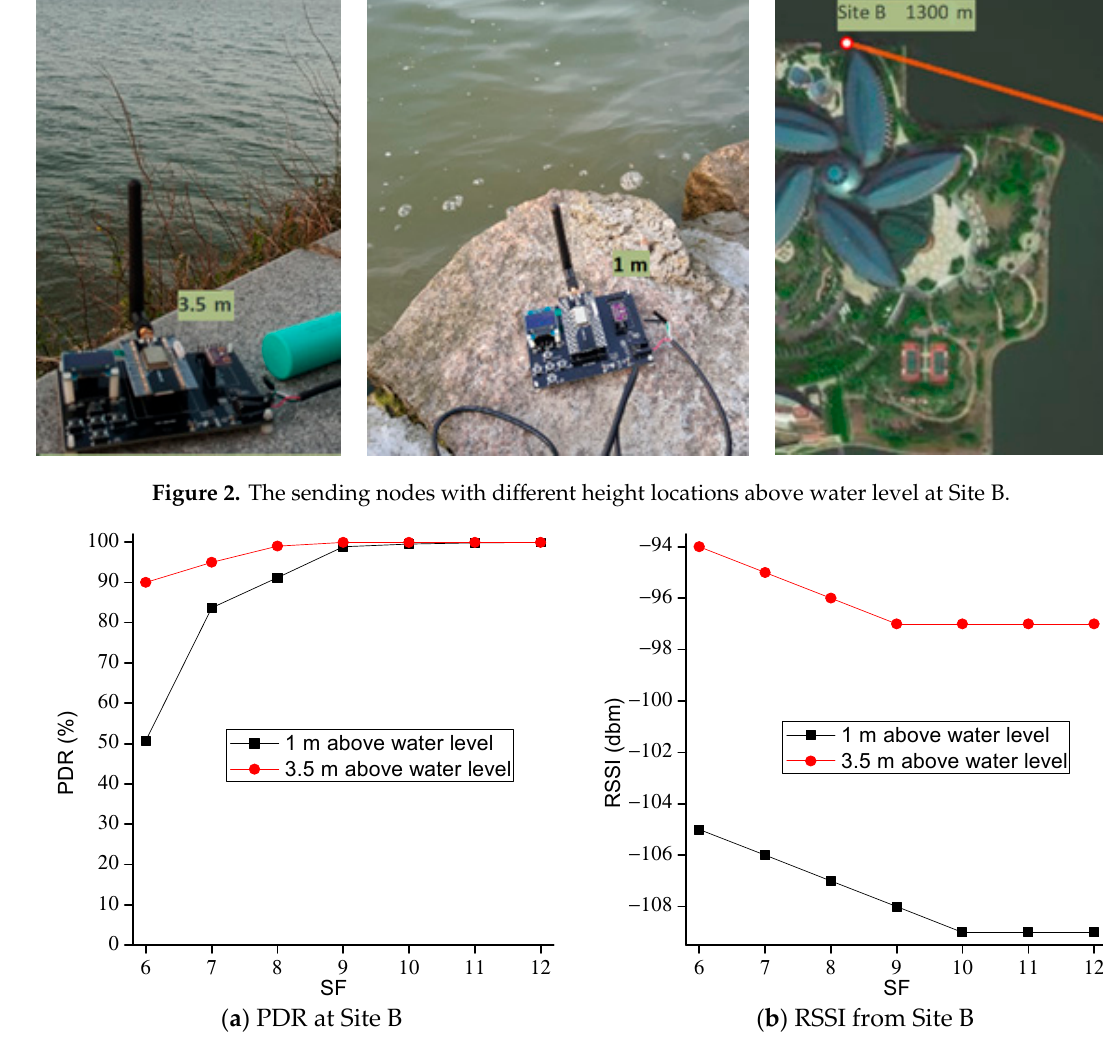
Figure 3. Performance testing at Site B.